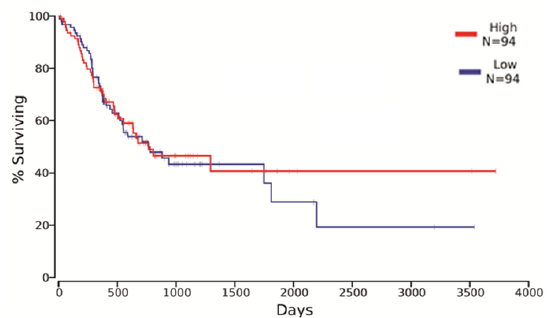
Fig. 2. Disease-free survival of gastric cancer patients based on HNF1A-AS1 expression levels in the TCGA cohort.